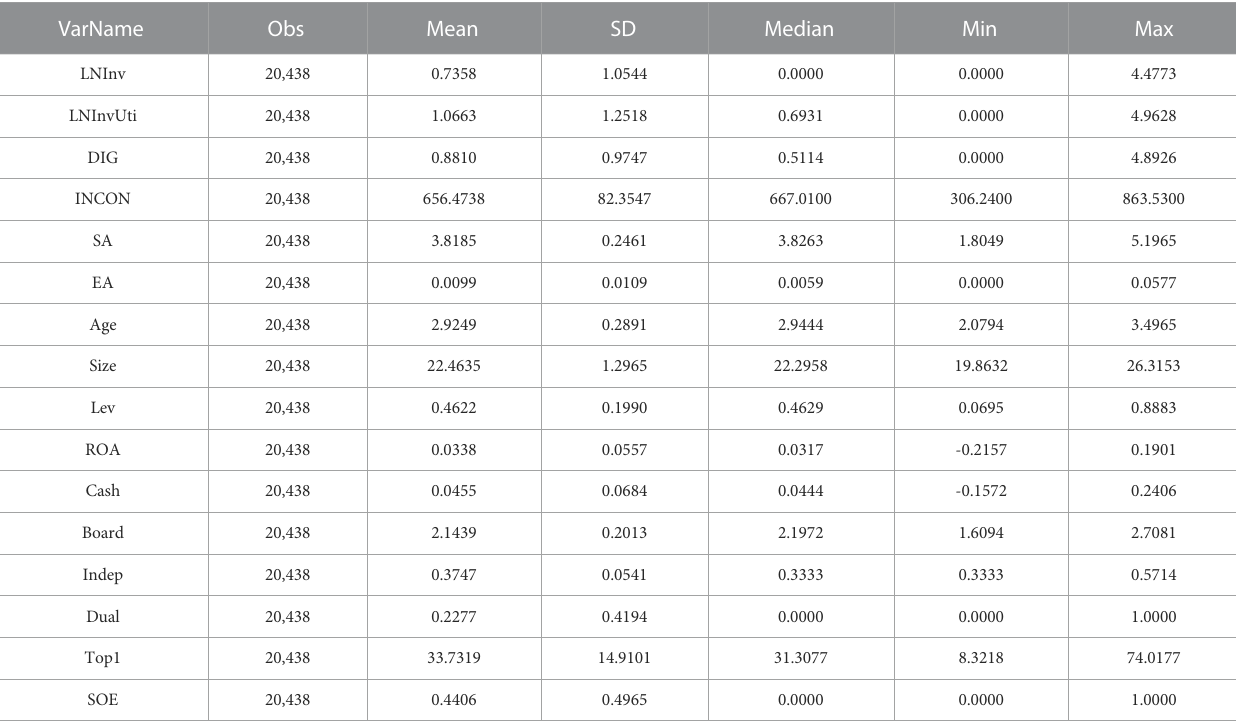
TABLE 3 Descriptive